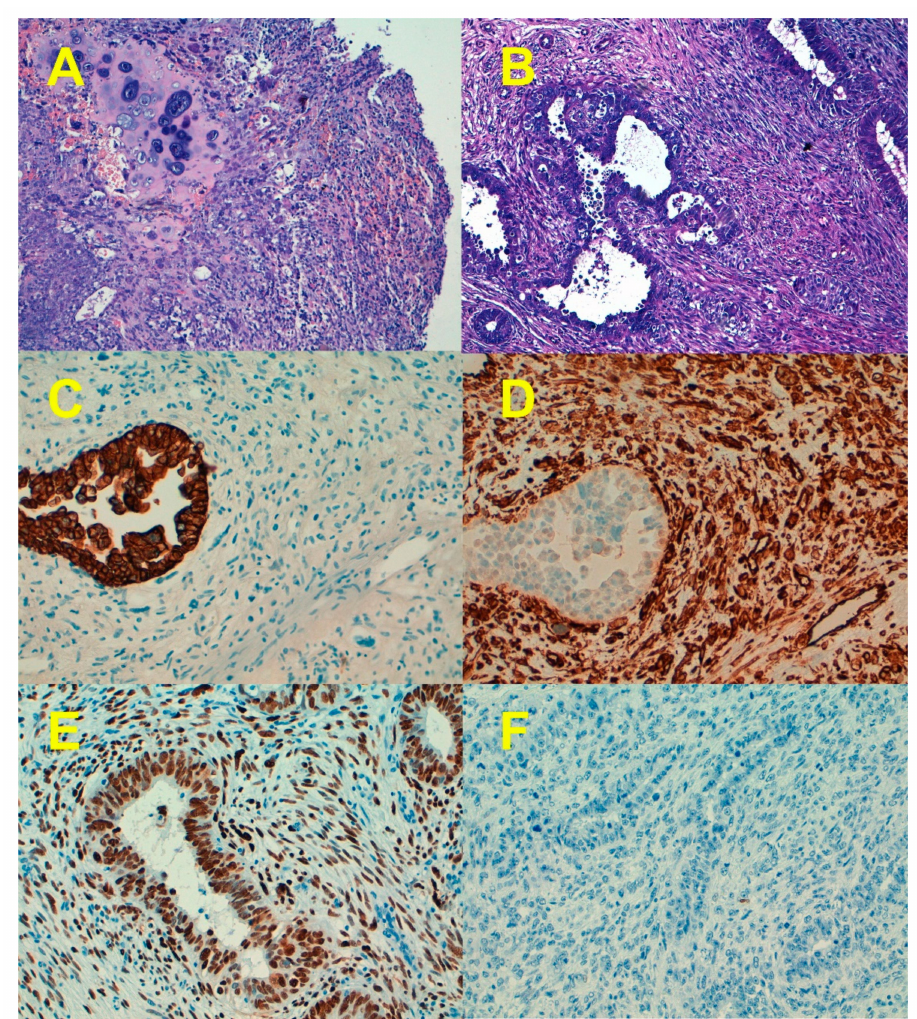
Figure 1. Morphological and immunohistochemical features of endometrial carcinosarcoma. ( A ) Hematoxylin-eosin staining of an endometrial carcinosarcoma showing the epithelial component surrounded by the heterologous mesenchymal component (chondrosarcoma). ( B ) Endometrial carcinosarcoma with homologous sarcoma (H&E). ( C ) Cytokeratin expression of the case depicted in b. ( D ) Vimentin expression in the case depicted in b. ( E ) p53 overexpression in both the carcinomatous and sarcomatous components. ( F ) p53 null pattern in both the carcinomatous and sarcomatous components. Only occasional normal stromal cells expressed p53. Original magnification 10 × for ( A , B ), and 20 × for ( C – F